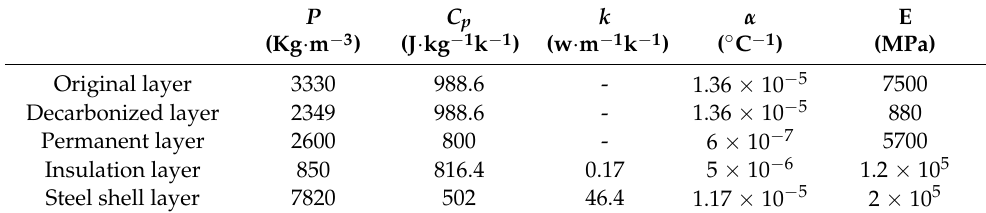
Table 2. Thermal conductivity of materials at different Table 3. Input parameters and boundary conditions used for CFD simulations.